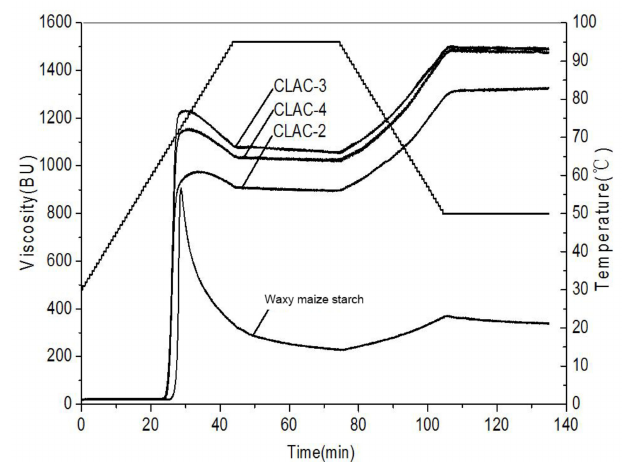
Figure 4. Brabender viscosity curve